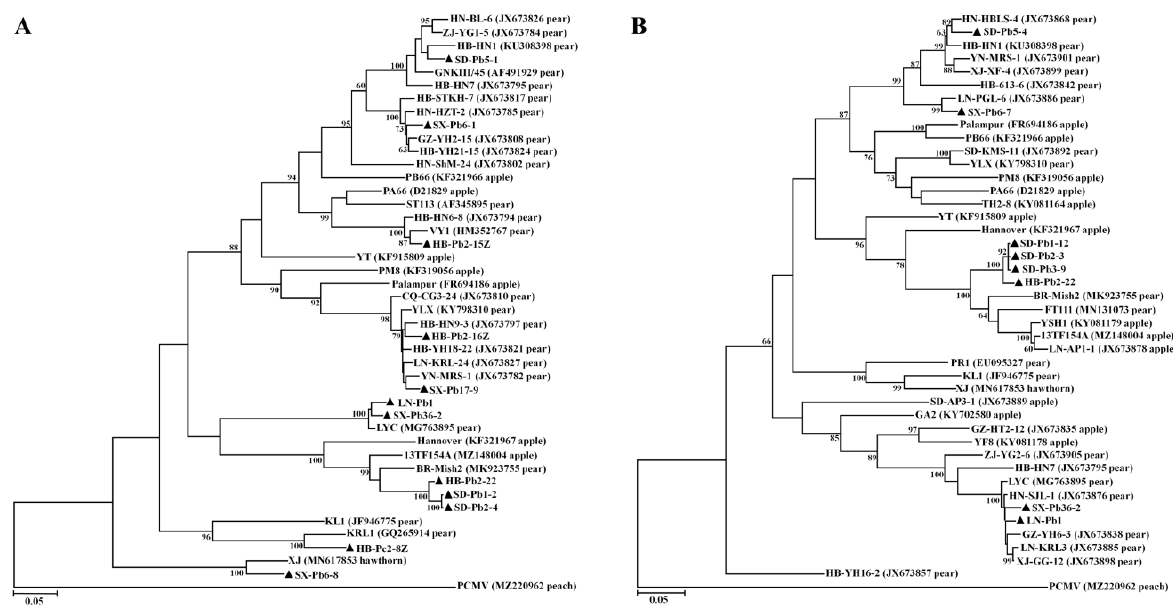
Figure 4. Unrooted maximum-likelihood (ML) phylogenetic trees generated from the nucleotide sequences of CP ( A ) and TGB ( B ) genes of apple stem pitting virus (ASPV). Each reported sequence was marked by its isolate name followed by a GenBank accession number and host name. The sequences determined in this study were highlighted by black triangles and marked by their geographic origins, hosts and clone IDs, and sequences from seeds were identified with ‘Z’. The corresponding sequence of peach chlorotic mottle virus (PCMV) was used as a outgroup in each phylogenetic tree.